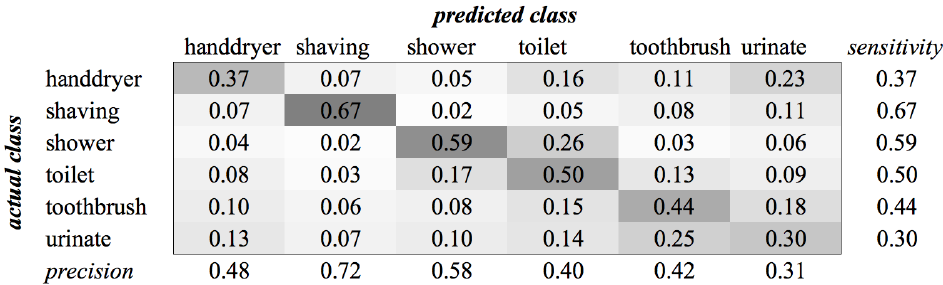
Figure A11. SVM confusion matrix of category Bathroom for MFCC feature type.